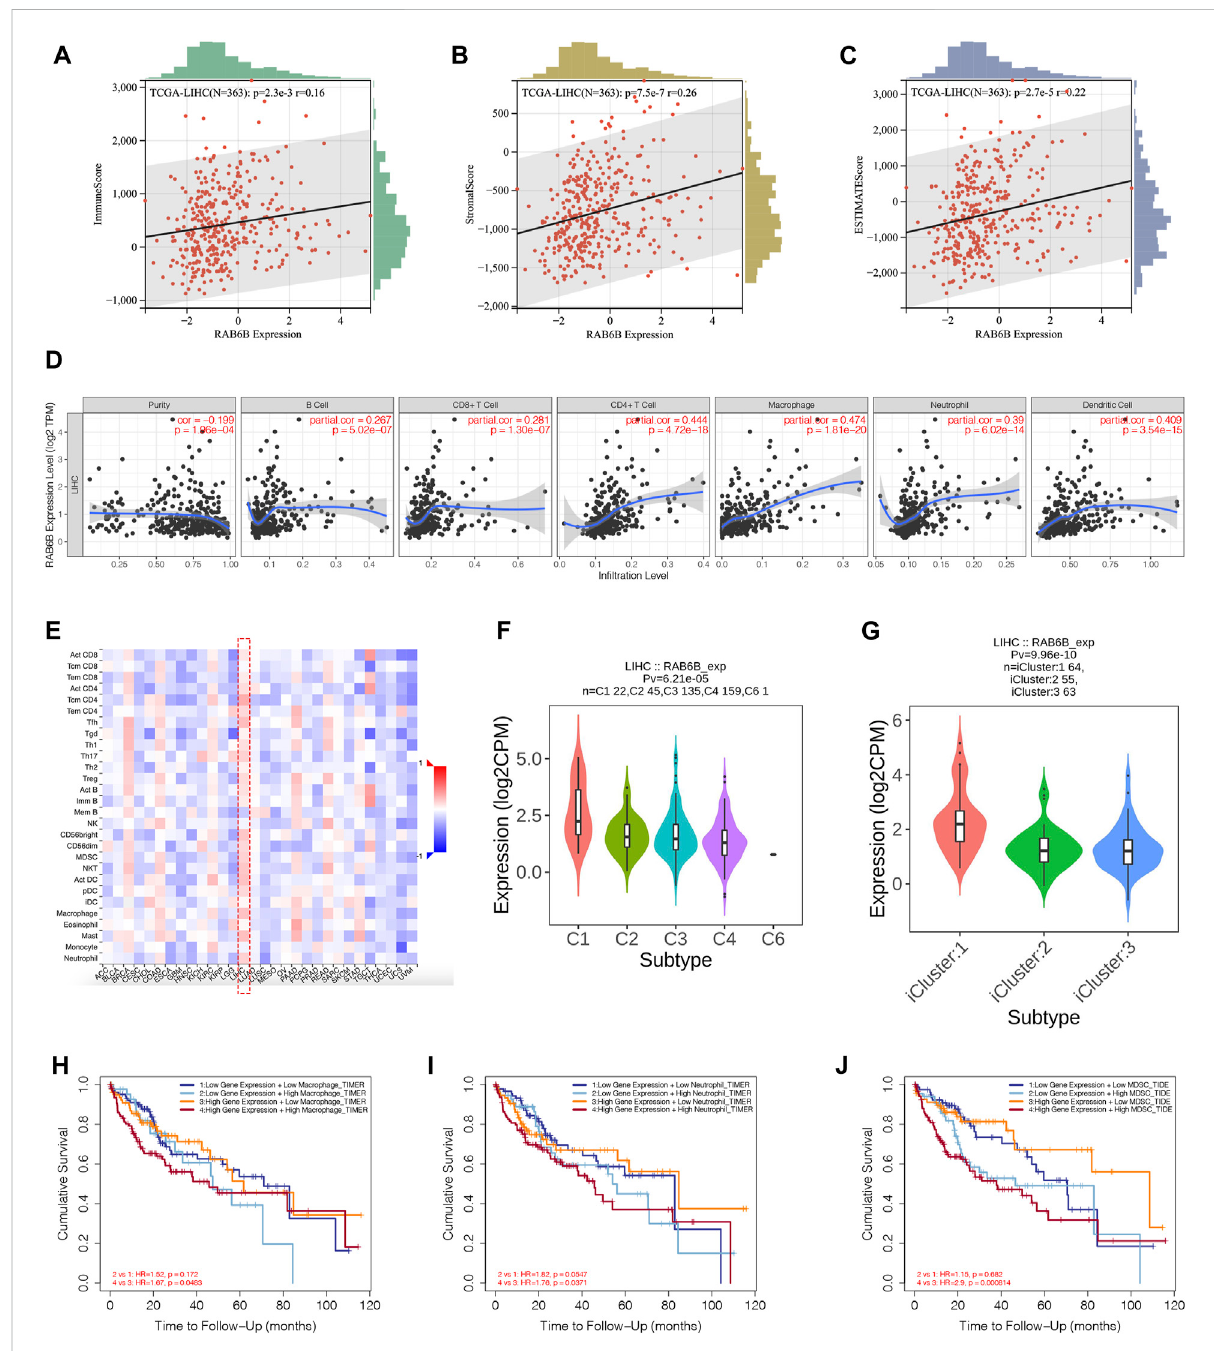
FIGURE 4 RAB6B expression correlated with tumor-in fi ltrating immune cells inHCC. (A – C) RAB6B expression waspositivelyassociated with theimmune scores (A) , stromal scores (B) , and estimate scores (C) in HCC patients from the TCGA database. (D) Correlation between RAB6B expression and the tumor-in fi ltrating immune cells in HCC from the TIMER database. (E) Heatmap showed the relationship between RAB6B and various types of immune cells in HCC (red dashed rectangle) from the TISIDB database. (F) Correlation between RAB6B expression and immune subtypes in HCC from TISIDB database. C1 (wound healing); C2 (IFN-gamma dominant); C3 (in fl ammatory); C4 (lymphocyte depleted); C5 (immunologically quiet); C6 (TGF-b dominant). (G) Association between RAB6B expression and various molecular subtypes in HCC from TISIDB database. (H – J) Cumulative survival analysis of combinations of RAB6B expression and the abundance of macrophage cells (H) , neutrophil cells (I) , and MDSC (J) in HCC from the TIMER2.0 database. MDSC, myeloid-derived suppressor